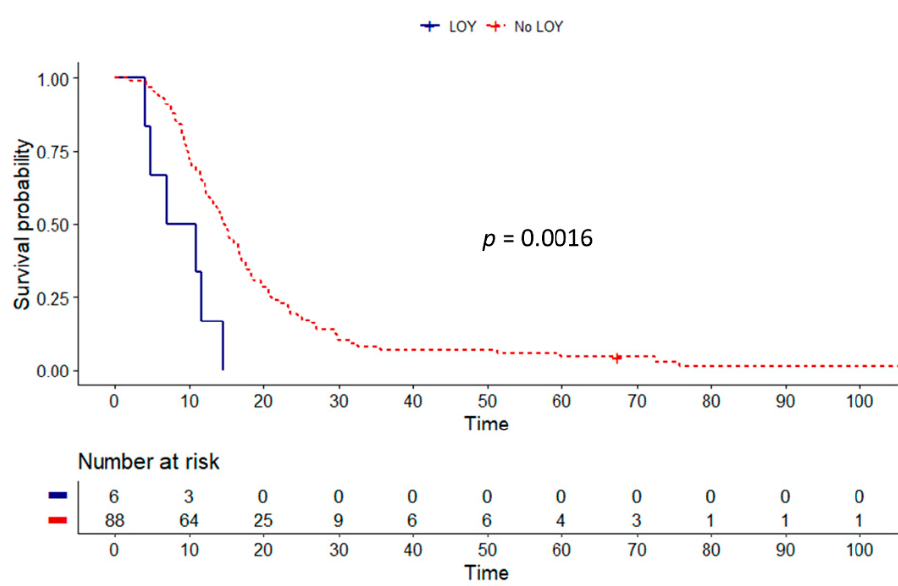
Figure 3. Kaplan–Meier log-rank survival analysis of patients with loss of chromosome Y (LOY) in GBM tumor tissue ( n = 94). LOY in GBM ( n = 6), defined as deletion of all 10 markers, correlates with shorter OS (7 vs. 14.5 months).